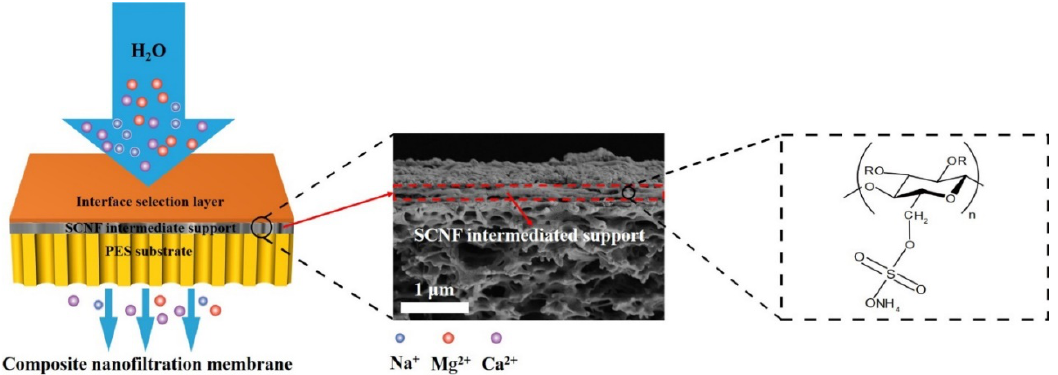
Figure 11. Novel composite nanofiltration membrane using sulfated cellulose nanofibril (SCNF) for nanofiltration. Reprinted/adapted with permission from Ref. [138].